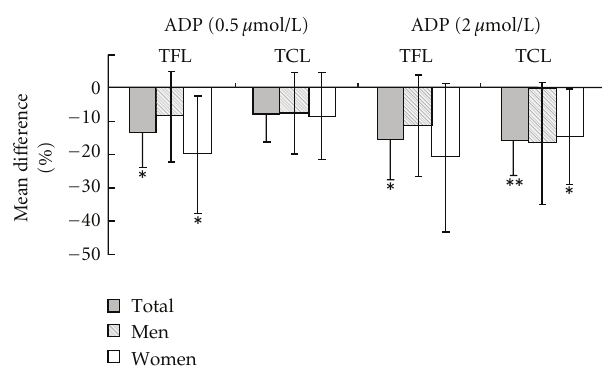
Figure 2: Mean di ff erences of 0.5 μ mol/L and 2 μ mol/L adenosine- diphosphate- (ADP-) induced platelet aggregation before and after the intervention. Values are means and 95% CIs. ∗ P < 0 . 05, compared with baseline; ∗∗ P < 0 . 01, compared with baseline. TCL, traditional Chinese liquor; TFL, tea-flavor